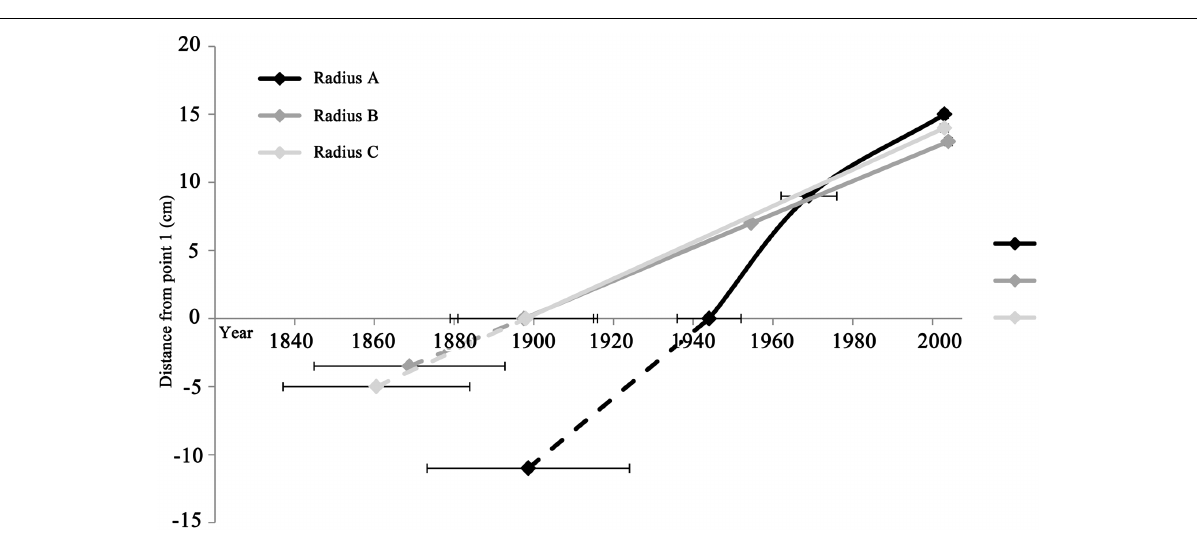
would have been possible based on radiocarbon alone.